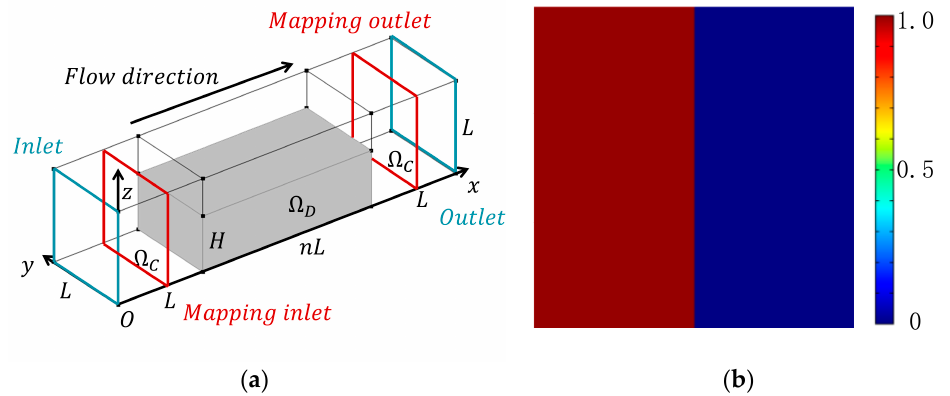
Figure 4. ( a ) Design domain Ω D of the micromixers at the bottom layer of the straight channel. Ω C is the channels connected to the inlet, outlet and design domain Ω D . The length of design domain Ω D is n times of L ; ( b ) the distribution of coarse grain concentration on the outlet.